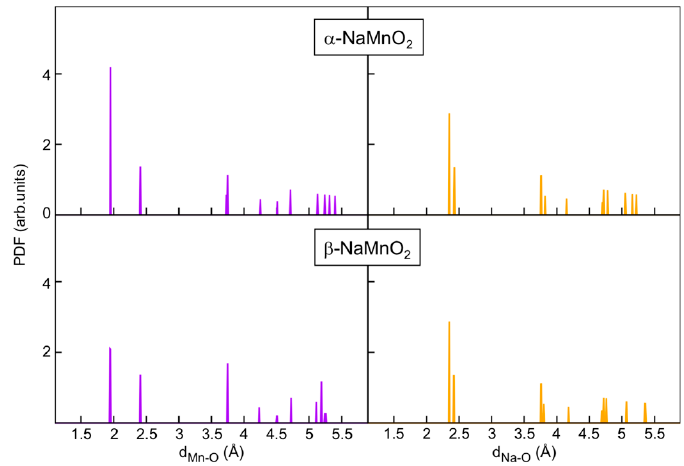
Figure 4. Pair distribution function of Mn-O (purple) and Na-O (orange) distances computed for α -NaMnO 2 ( top ) and β -NaMnO 2 ( bottom ) structures at PBE+U-D3BJ level of theory. Turning to the electronic structure, it has been investigated by means of projected density of states (pDOS) as shown in the Figure 5.